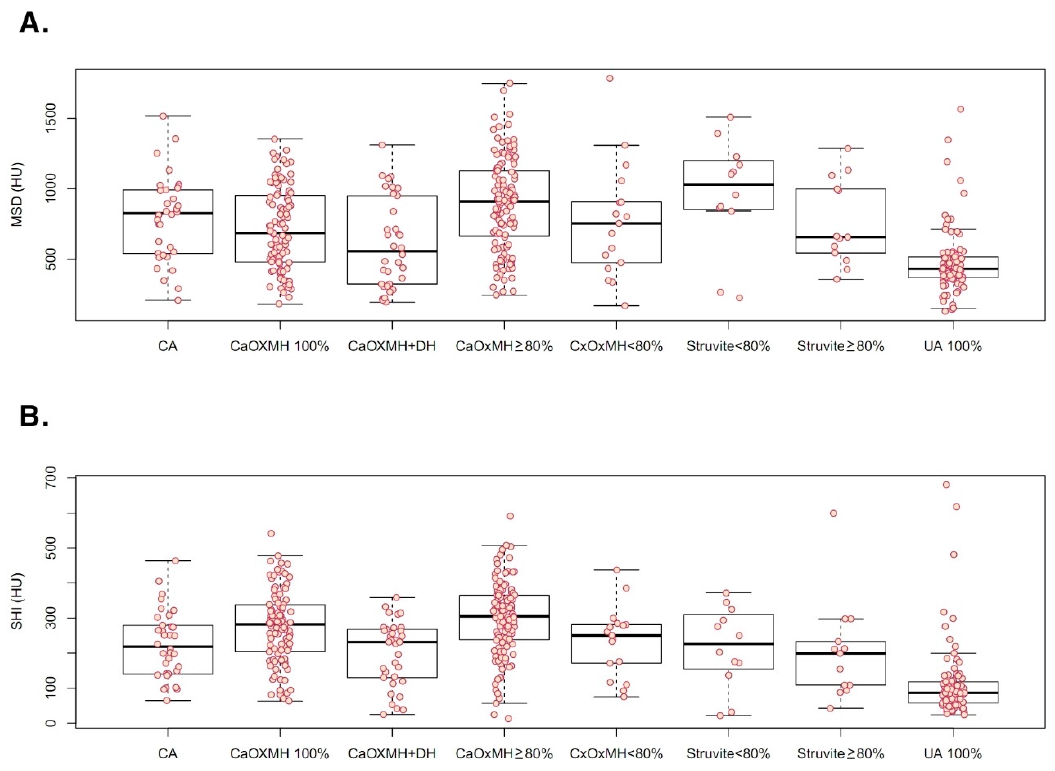
Figure 1. Mean stone density (MSD) ( A ) and stone heterogeneity index (SHI) ( B ) determined via non-contrast computed tomography and shown by stone composition. CA: carbonate apatite; CaOx: calcium oxalate; MH: monohydrate; DH: dihydrate; UA: uric acid; HU, Hounsfield unit.